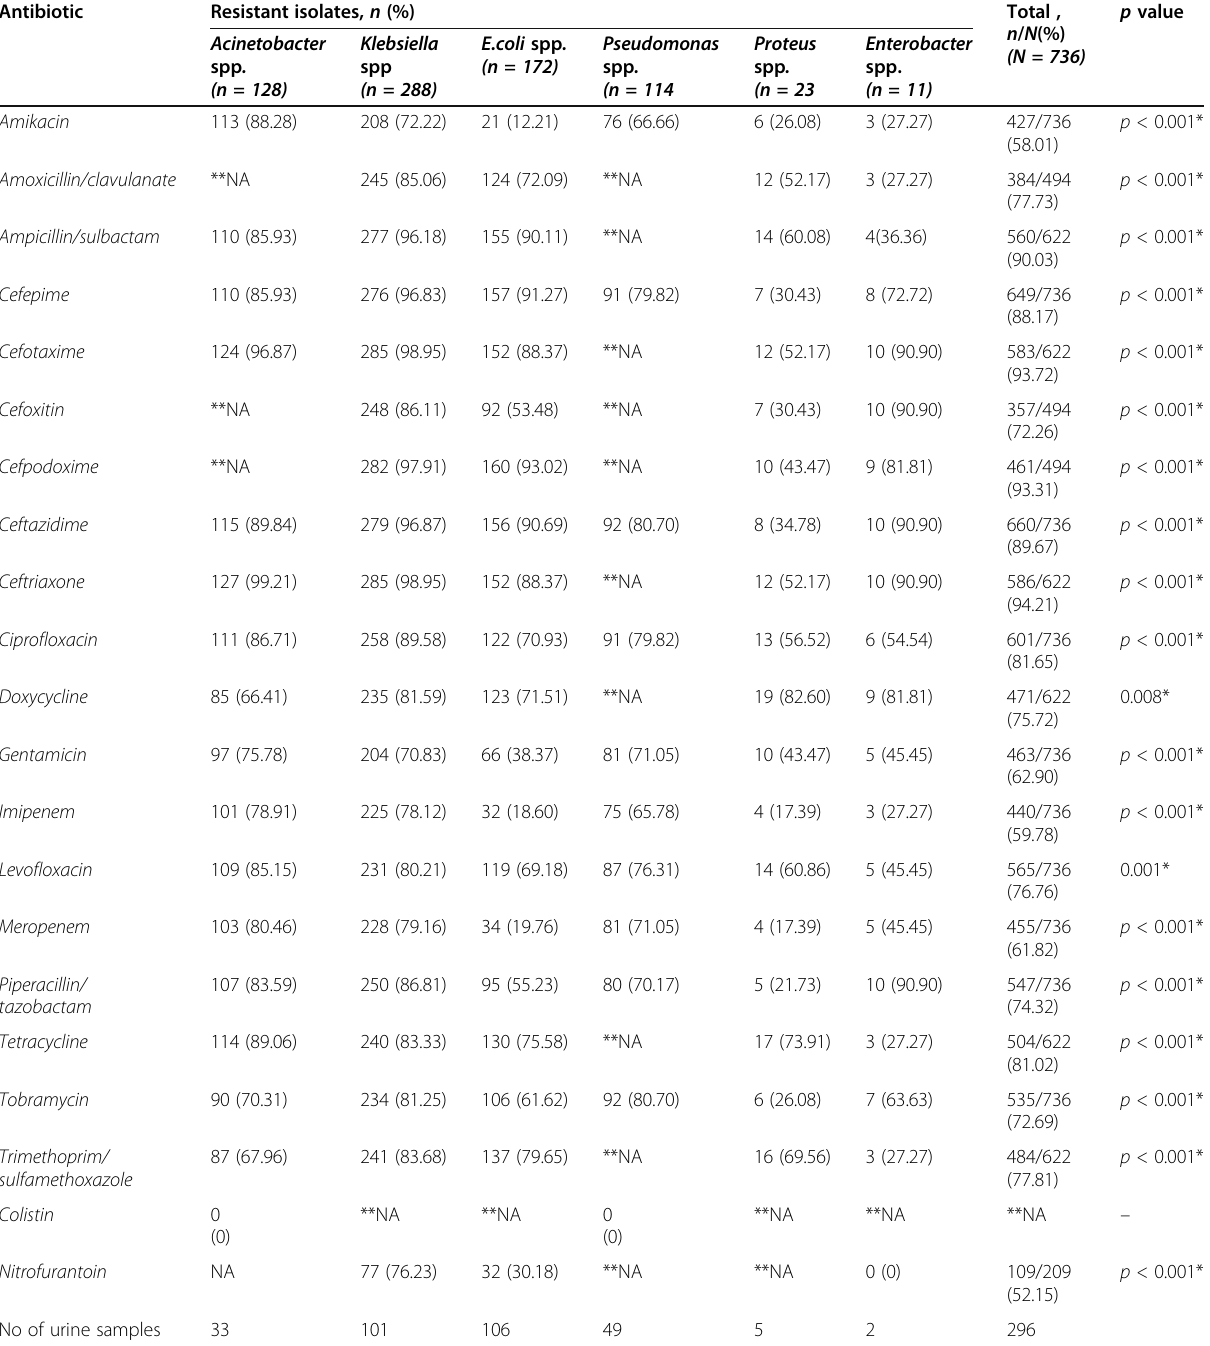
Table 3 Antibiotic resistance pattern of the prevalent gram-negative pathogens isolated from patients admitted in ICU, Ain Shams University Hospitals, Egypt, March 2018-February 2019